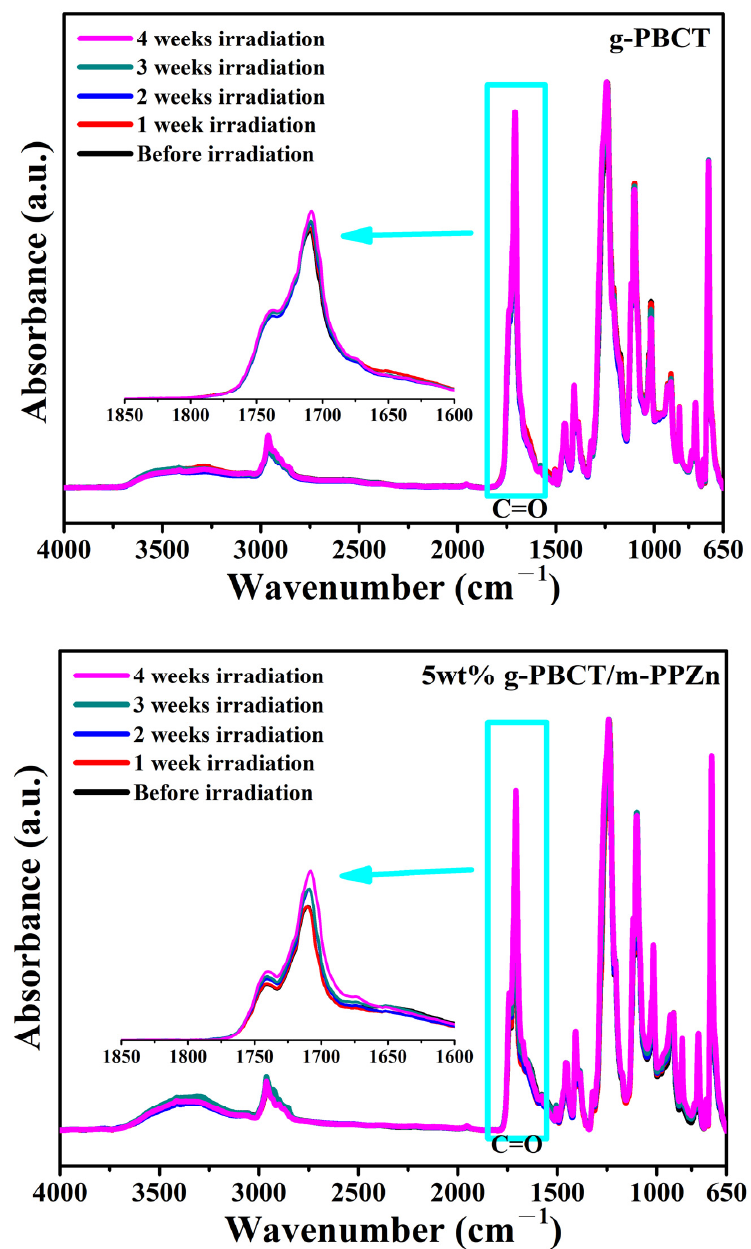
Figure 6. Change of FTIR spectra of g-PBCT and 5 wt% g-PBCT/m-PPZn composites nanocomposites at different UV irradiation times.